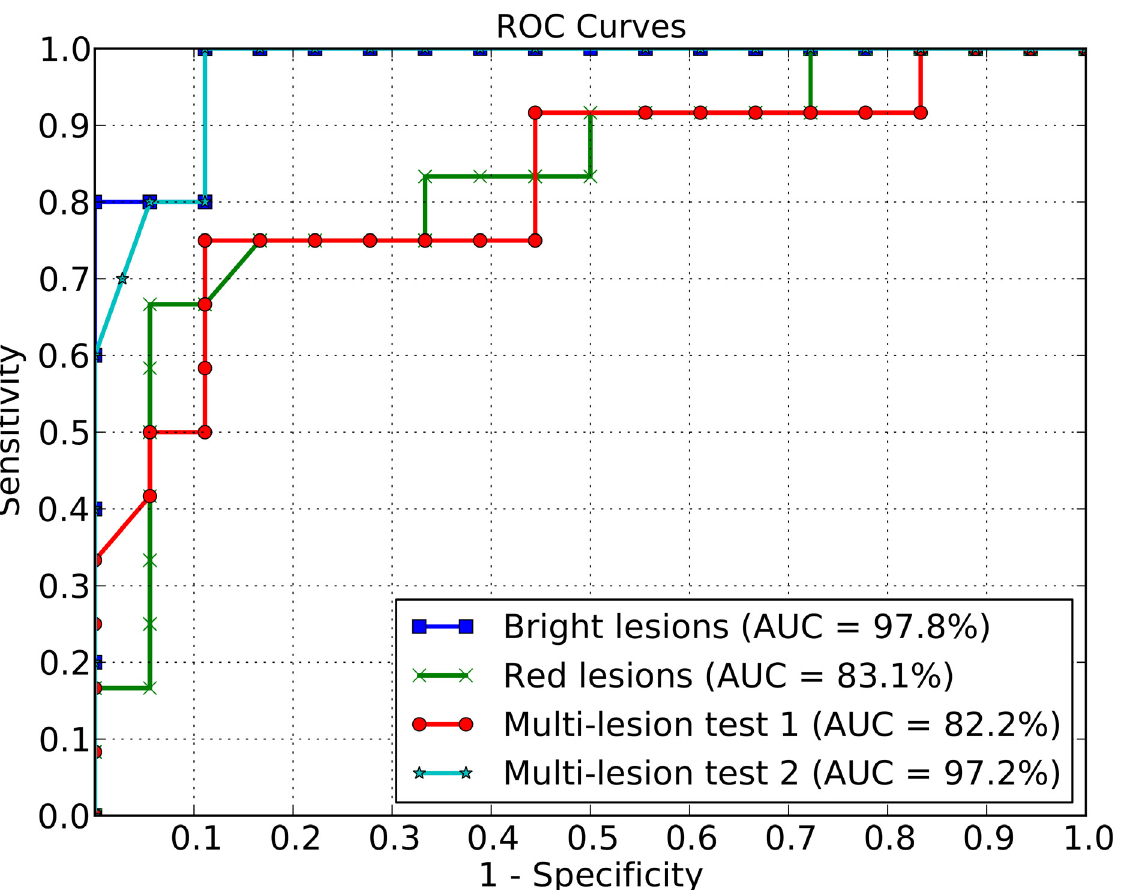
Fig 4. ROC curves. Red lesion, bright lesion, and multi-lesion